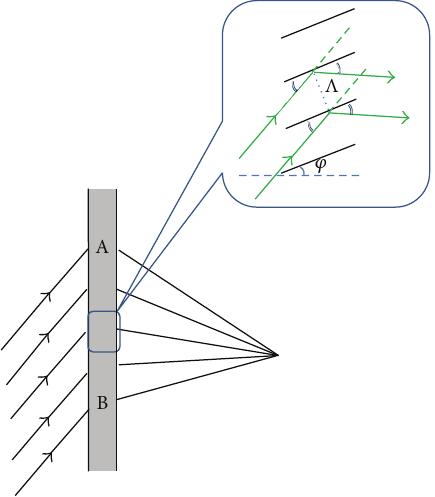
Figure 1: Schematic of the diffractive optical elements (DOEs) which redirects the incident light to an off-axis focus point, with inset showing typical fringe structure. Where Λ is the fringe spacing and 𝜑 is the angle between the fringes and the normal to the plane of the recording